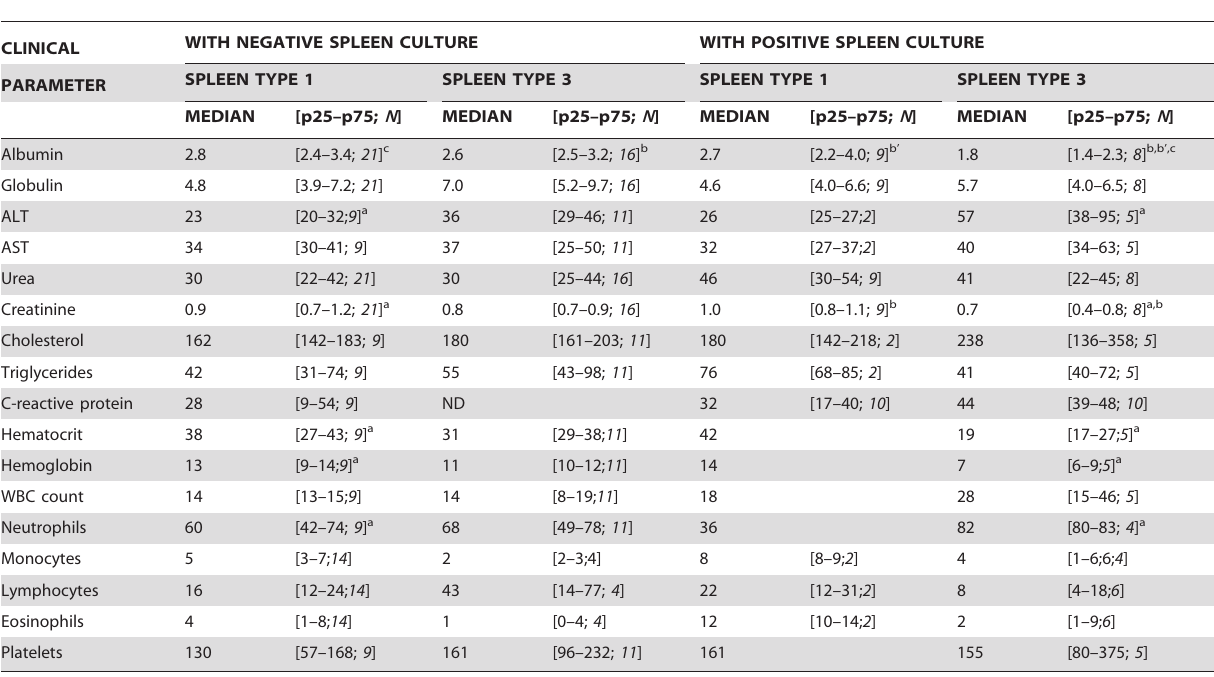
Table 5. Distribution of laboratory results in dogs with quiescent (negative spleen culture) or active (positive spleen culture) infection by L. infantum and type 1 (normal) or type 3 (moderately to severely disorganized) splenic white pulp